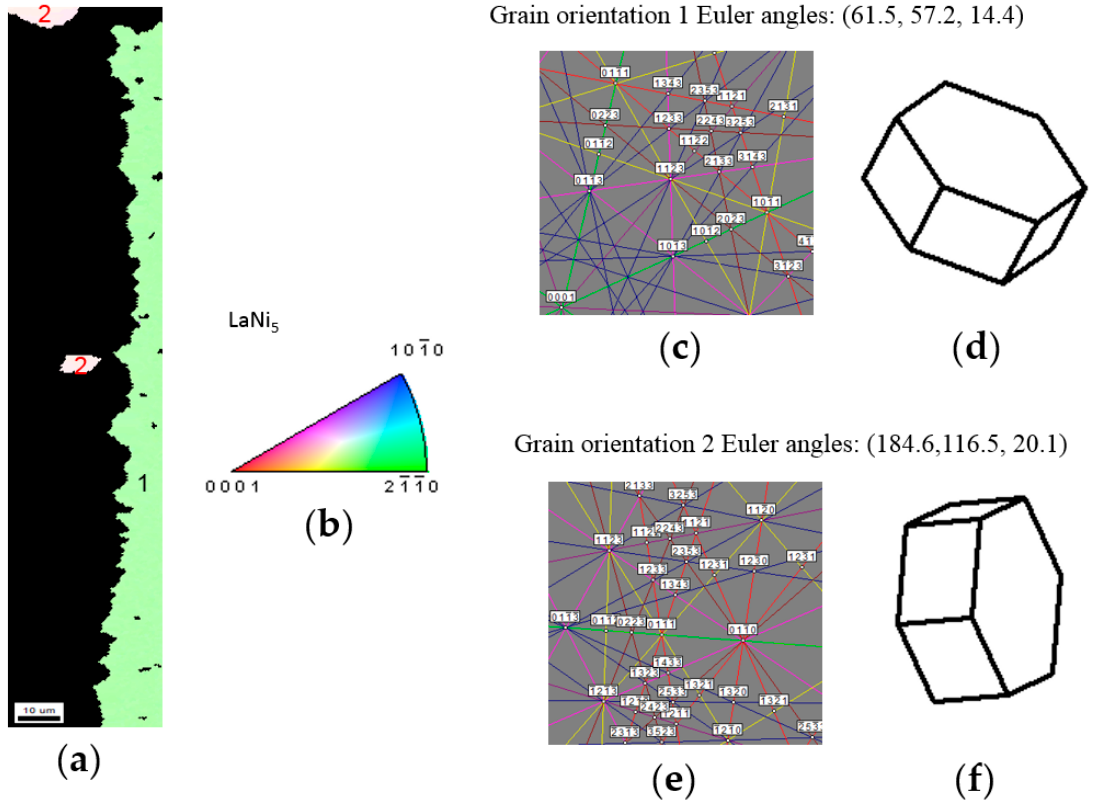
Figure 8. ( a ) IPF and EBSD mapping; ( b ) color assignment; ( c ) EBSD pattern for grain orientation 1 and ( d ) its corresponding crystal simulation; and ( e ) EBSD pattern for grain orientation 2 and ( f ) its corresponding crystal simulation of the LaNi 5 phase of the 16-h annealed sample.